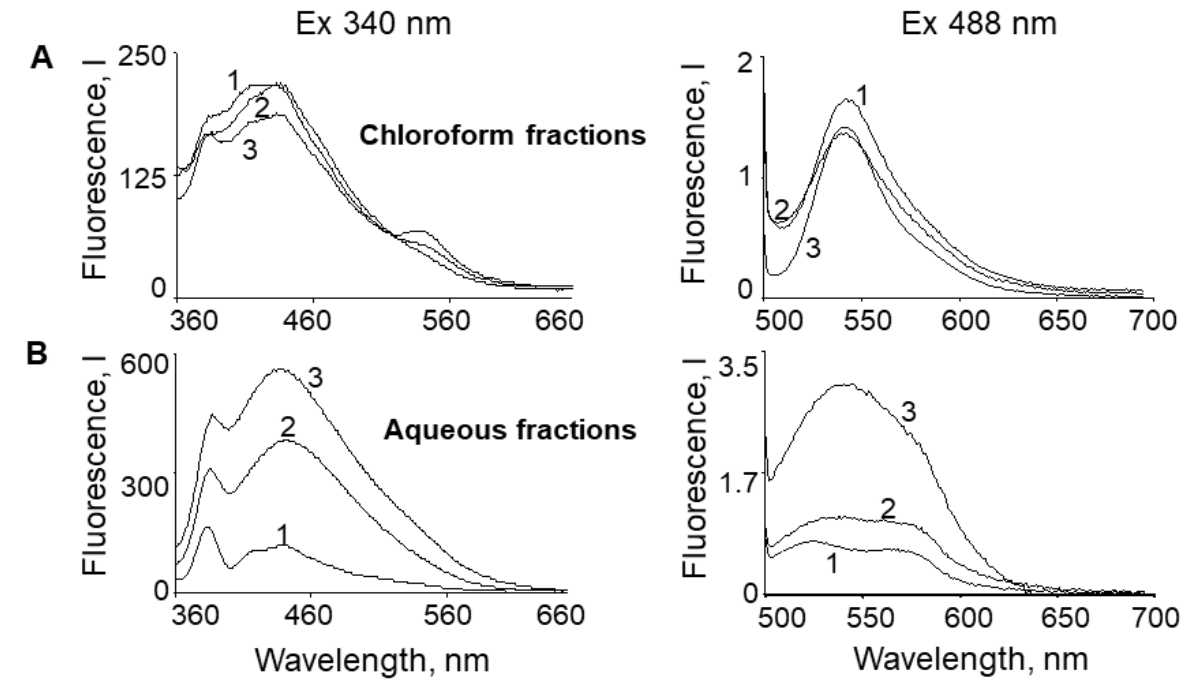
Figure 2. Fluorescence spectra of chloroform ( A ) and aqueous ( B ) fractions of the supernatants during extraction. 1 — control: supernatant fractions from the original (control) lipofuscin granule (LG) suspension, 2 — supernatant fractions from LG suspension irradiated for 30 min, and 3 — supernatant fractions from LG suspension oxidized with superoxide. The wavelengths of fluorescence excitation were 340 nm (left) and 488 nm (right).